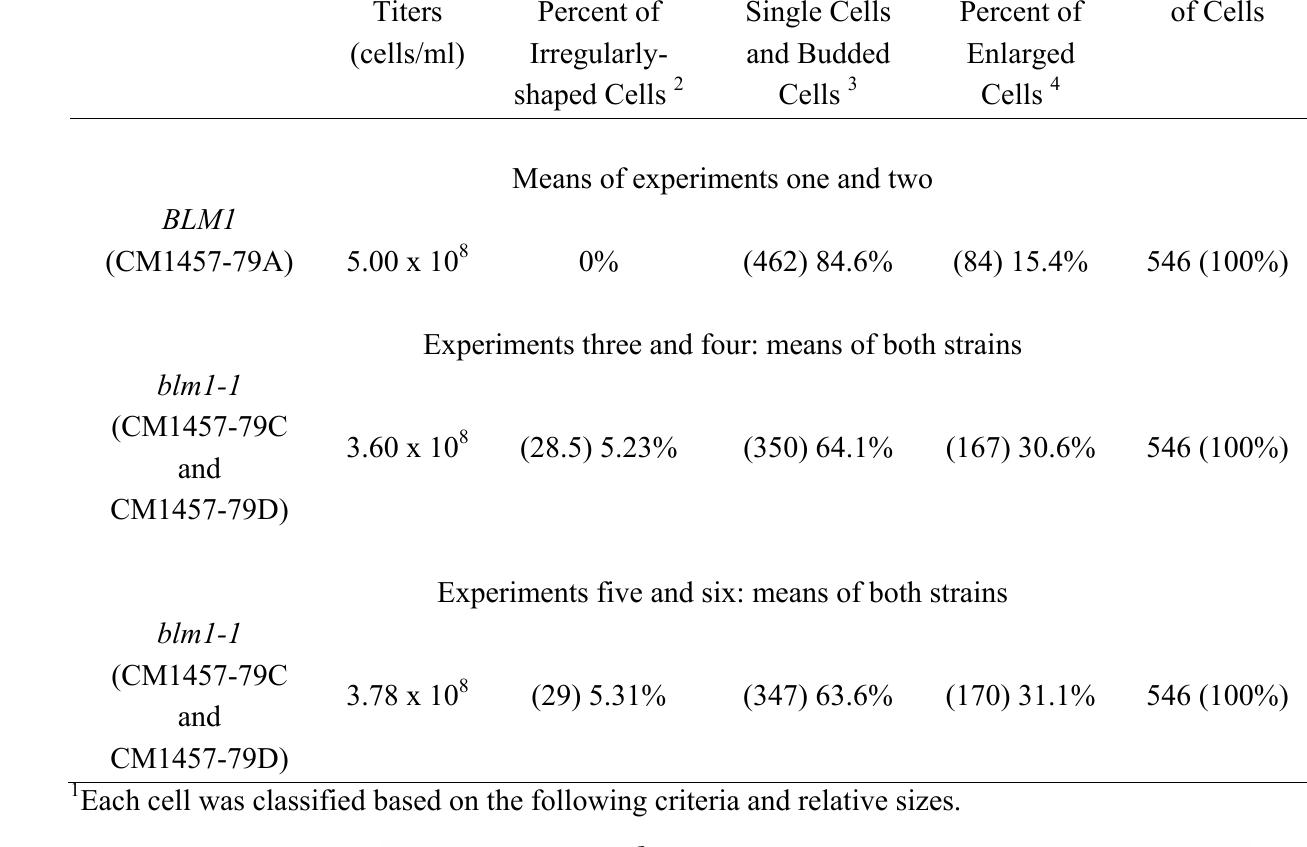
Table 3. Comparisons of Growth and Abnormally-shaped Cells in BLM1 and blm1-1 Strains 1